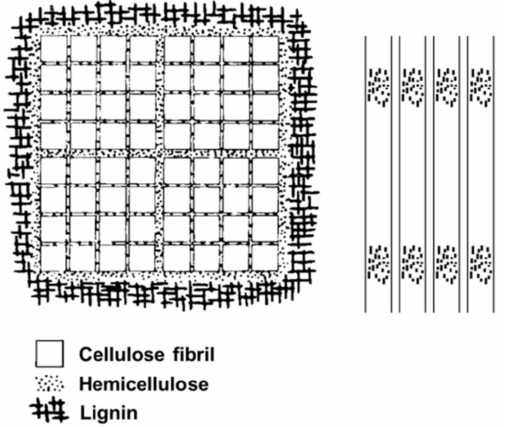
Figure 14. Models of cell wall components developed by